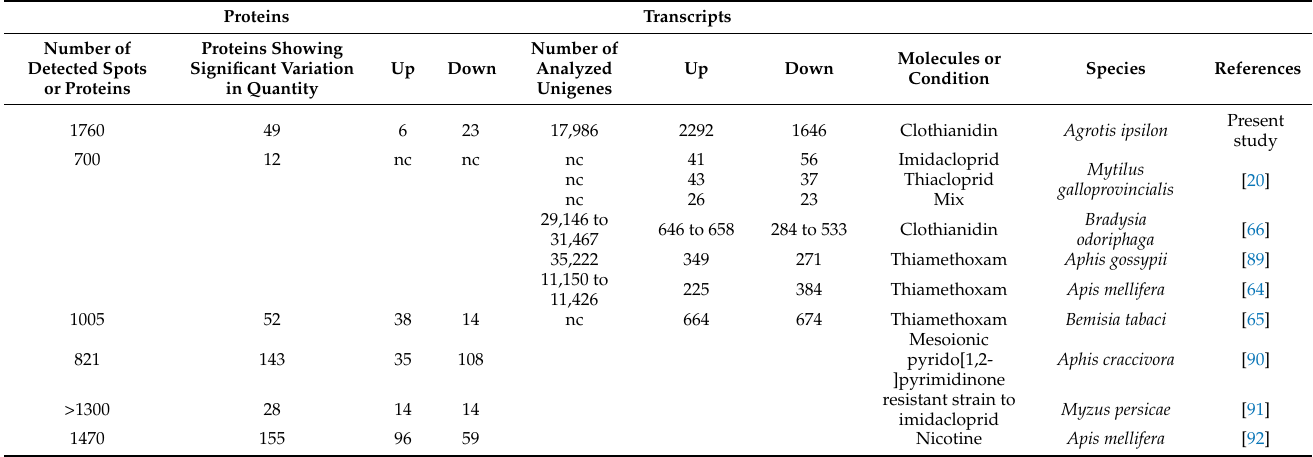
Table 5. Ecotoxicological studies using transcriptomics and proteomics methods. Proteins